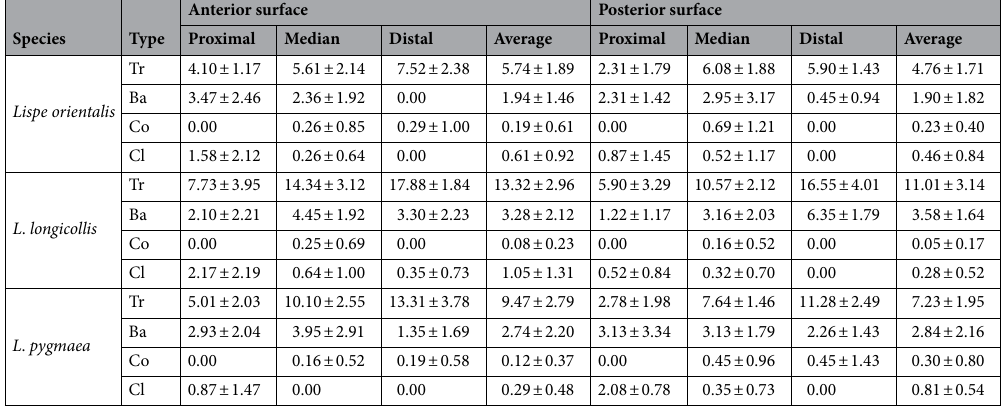
Table 3. Average density of sensilla (10 −3 μm −2 ± SD, n = 10) on antennal postpedicel of three Lispe species. Ba basiconic sensilla, Cl clavate sensilla, Co coeloconic sensilla, Tr trichoid sensilla.